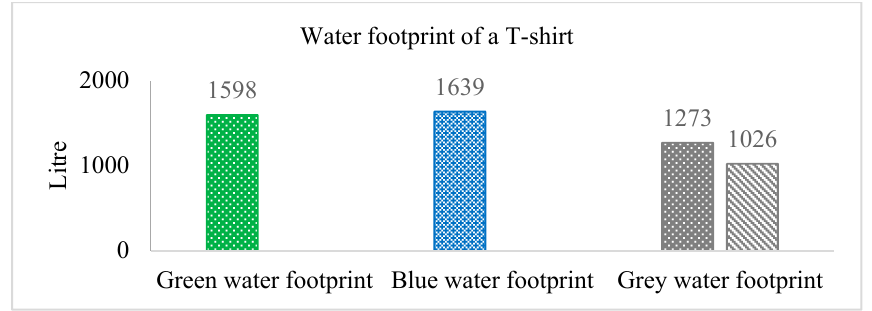
Figure 12. Water footprint of a T-shirt; with and without having functional ETP and STP the grey water footprint would be 1026 L and 1273 L, respectively.